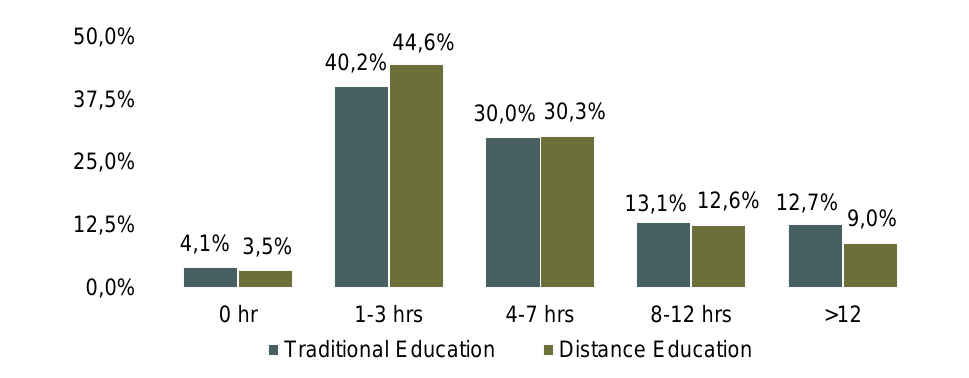
Fig. 6. Hours devoted to study per